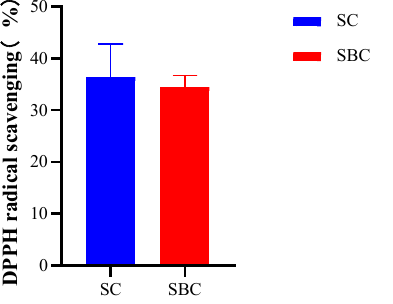
Figure 4. Scavenging rates of C. idella skin collagen (SC), swim bladder collagen (SBC) on DPPH free radicals.